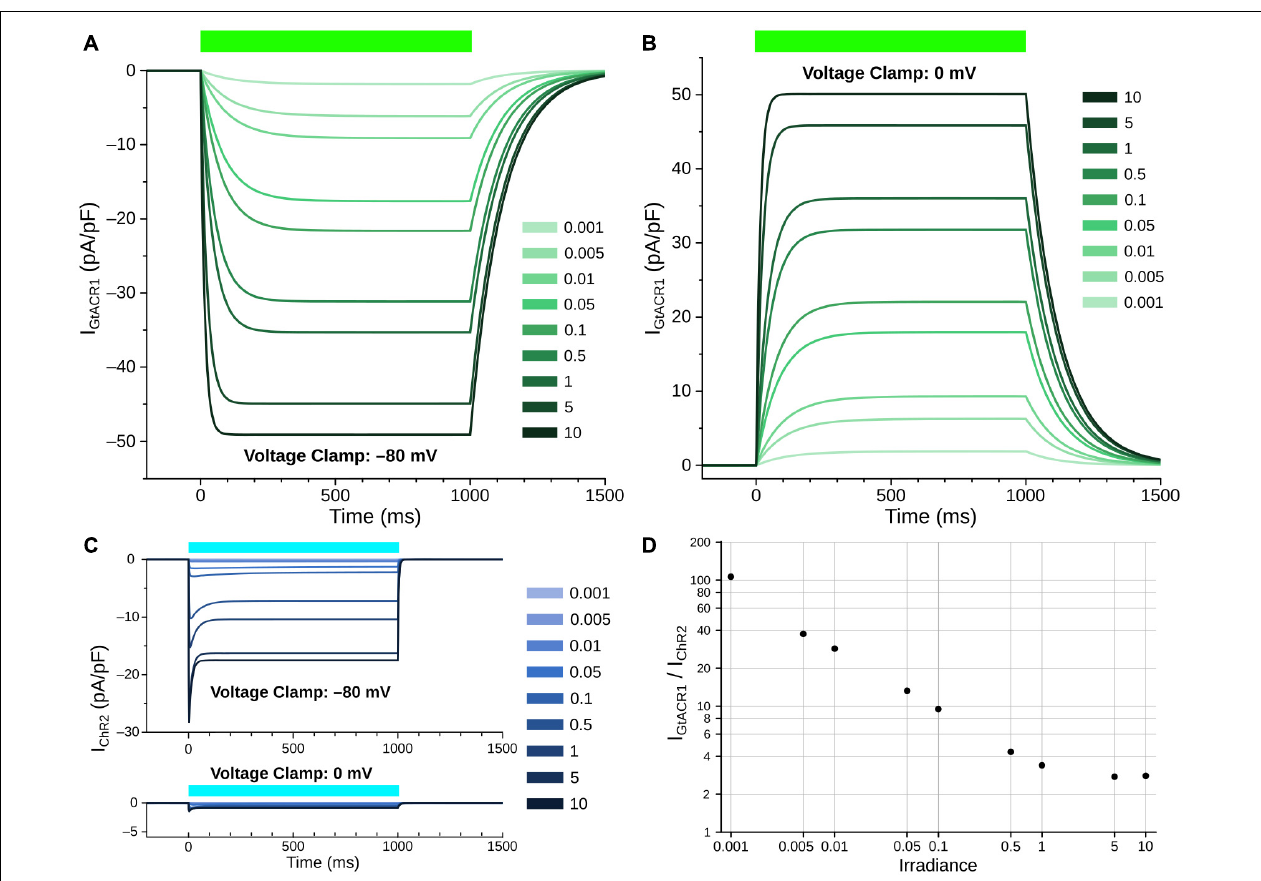
FIGURE 2 | Simulated GtACR1 and ChR2 currents in illumination voltage forcing experiments. (A,B) Photocurrent conducted by GtACR1 generated in response to illumination with holding potentials of –80 (A) and 0 mV (B) . (C) Same as A/B but for ChR2. (D) Comparison of steady-state I GtACR 1 and I ChR 2 values (plateau currents at t = 500 ms) for different irradiances under voltage clamp condition. In all panels, units of irradiance are mW/mm 2 . Colored bars: intervals of illumination with green (515 nm; 1000 ms) or blue light (488 nm, 1000